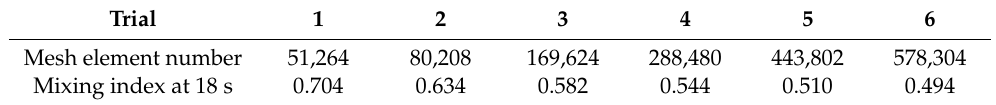
Table 1. Grid independency test of basic geometry, evaluated using MI at t = 18